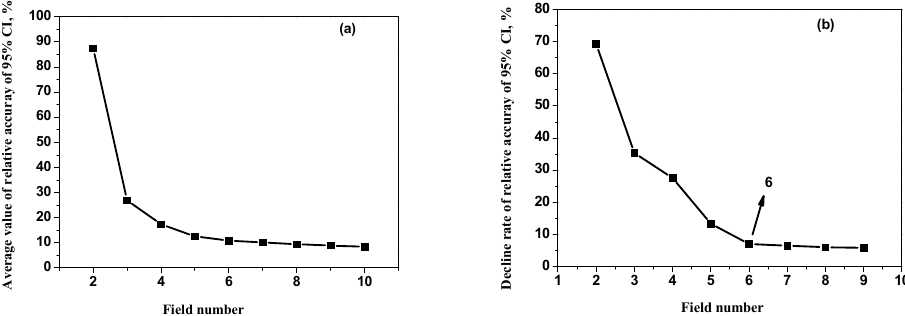
Figure 12. The variation curves of the average relative accuracy of 95% confidence interval ( a ) and its decline rate ( b ) with different fields for X90 steel.